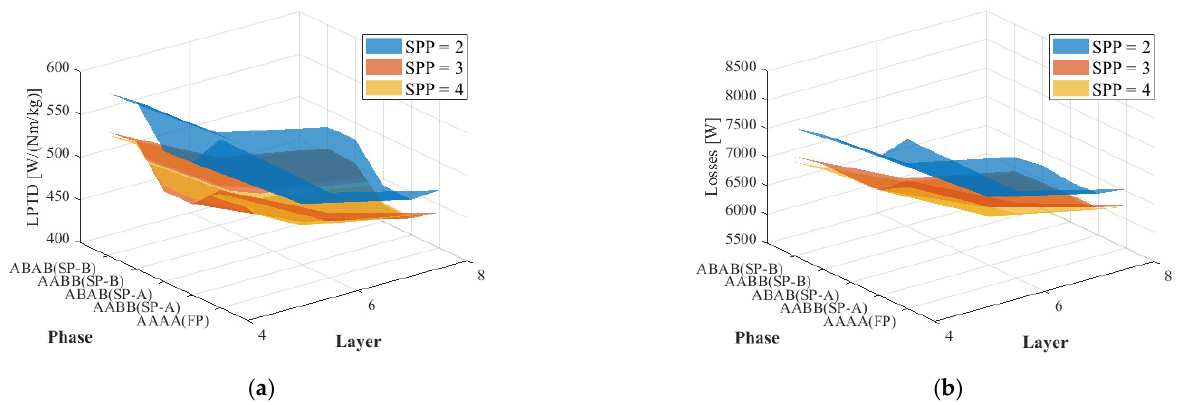
Figure 13. Comparison of FE-calculated LPTD values and total AC losses for the baseline IPM machines as a function of phase arrangement and number of layers for three SPP values (excitation condition: 400 Arms at 200 Hz): ( a ) LPTD values; ( b ) Total losses.